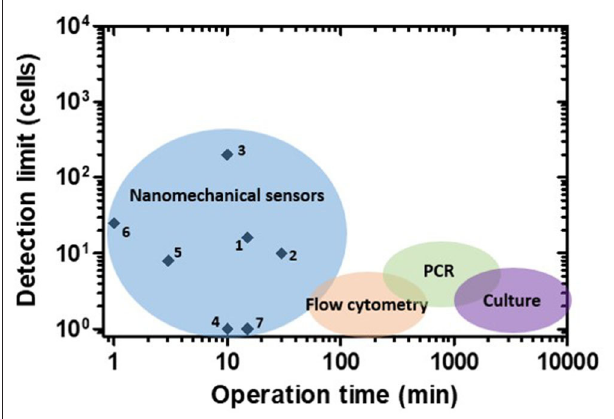
FIGURE 5 | Performance of nanomechanical sensors for bacteria detection. Operation time vs. detection limit plot for nanomechanical sensors and some of the most widespread conventional methods. Numbers correspond to references as follows: 1: Ilic et al. (2000), 2: Gupta et al. (2004), 3: Gfeller et al. (2005a) , 4: Burg et al. (2007), 5: Mader et al. (2012), 6: Weeks et al. (2006), 7: Cermak et al. (2016).